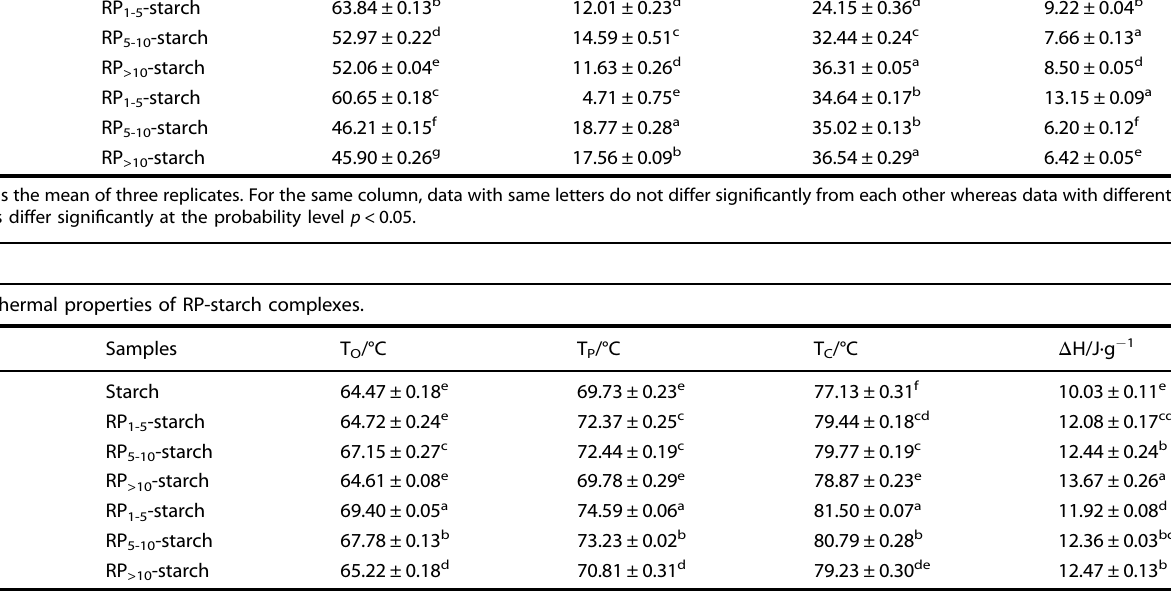
Table 1. The values for RDS, SDS, RS fractions, and digestion rate coef fi cient of RP-starch complexes. Addition